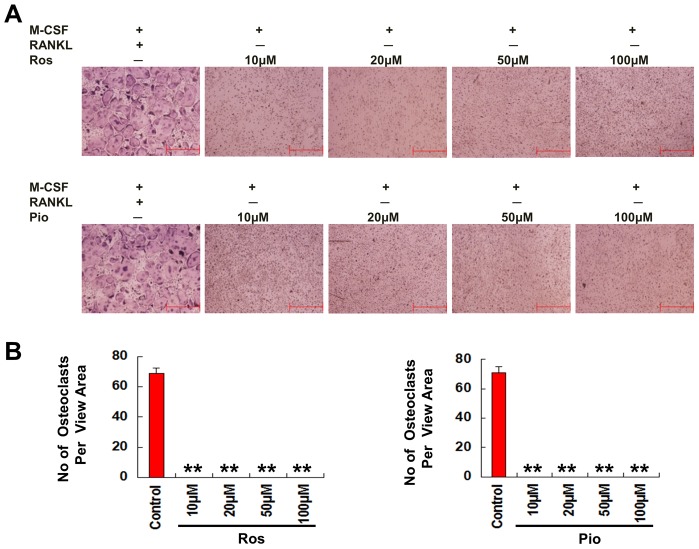
Rosiglitazone and pioglitazone do not induce osteoclastogenesis in the absence of RANKL.(A) BMMs were treated with M-CSF (44 ng/ml) and RANKL (100 ng/ml) as control, or M-CSF (44 ng/ml) plus different doses (10 µM, 20 µM, 50 µM and 100 µM) of rosiglitazone (Ros) or pioglitazone (Pio) for 4 days. The cultures were stained for TRAP activity. All assays were performed in triplicate and repeated 3 times. One representative view from each condition is shown. (B) Quantification of the osteoclastogenesis assays in A for Ros (left panel) and Pio (right panel). The number of multinucleated TRAP-positive cells (>3nuclei) per representative view area (40× magnification) was obtained. Bars show averages of three replicates ±S.D. TZD-treated cultures were compared with control cultures. **: P<0.001.